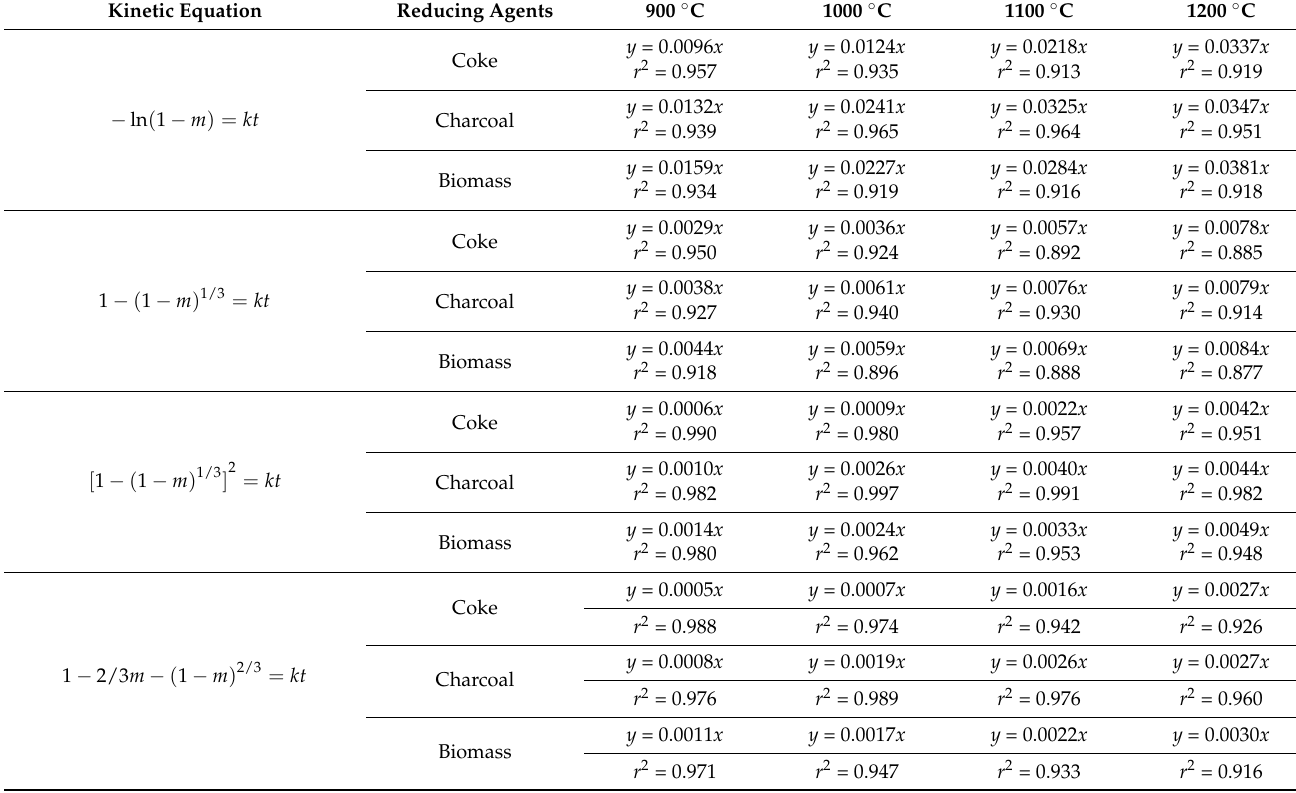
Table 3. Lines of kinetic model parameters for various kinetic reduction